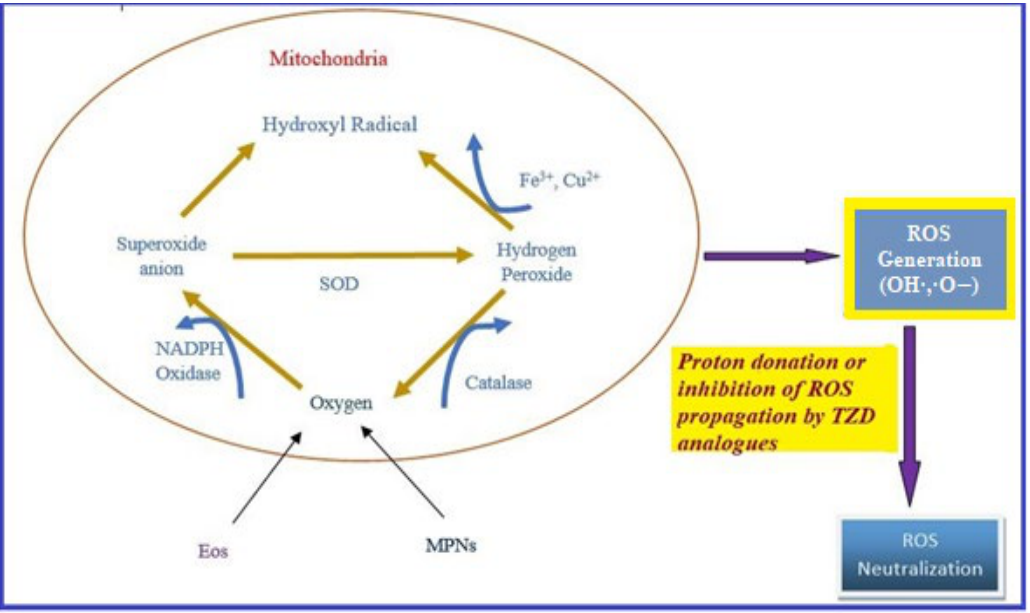
Figure 8. ROS generation and antioxidant scavenging mechanism of TZDs.